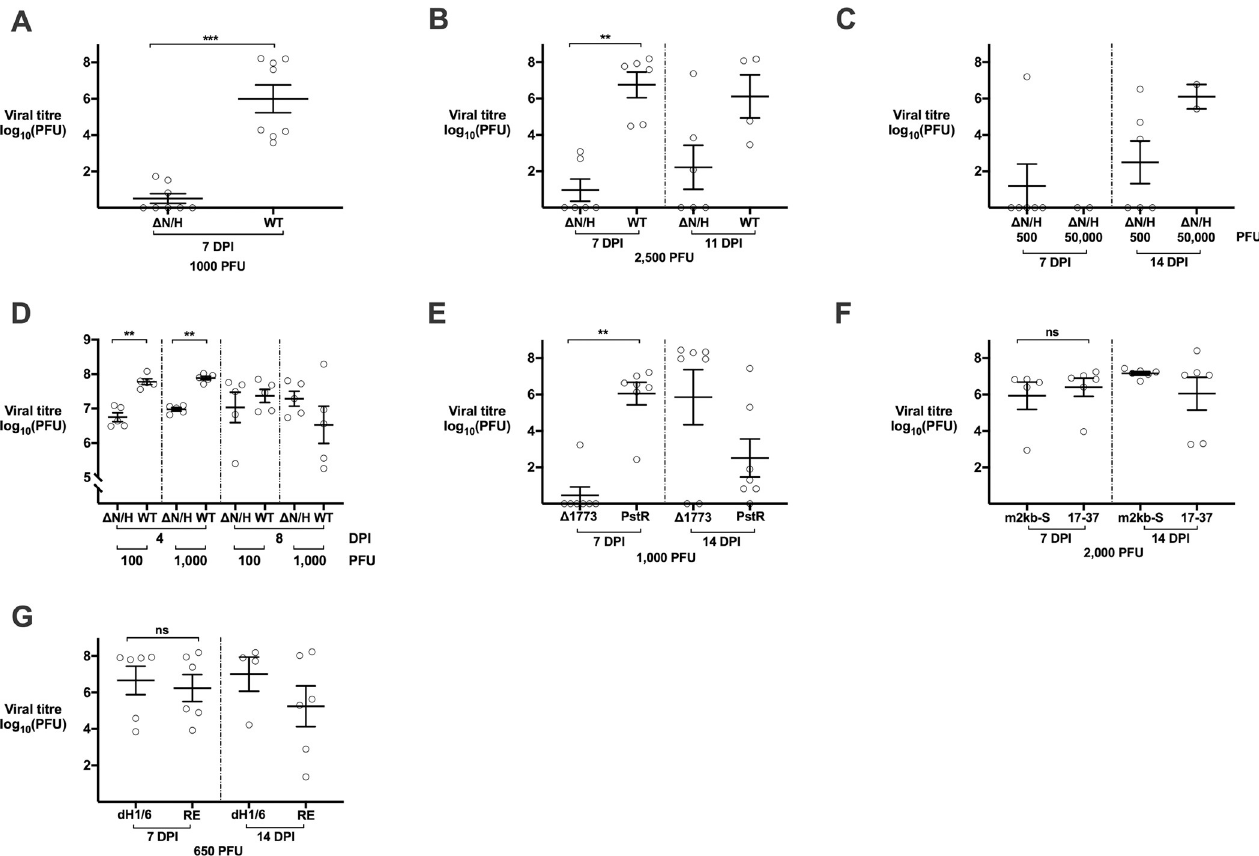
Fig 3. Replication of 17 syn + and LAT mutant viruses in human skin in vivo and cultured skin explants. Viral titres (log 10 PFU/implant ± SEM; each data point represents an individual replicate) recovered from: (A) in vivo skin xenografts infected with 1,000 PFU 17 Δ N/H ( Δ N/H) or 17 syn + (WT) at 7 DPI (n = 8); (B) in vivo skin xenografts infected with 2,500 PFU 17 Δ N/H or 17 syn + at 7 (n = 6) or 11 DPI (17 Δ N/H n = 6; 17 syn + n = 4); (C) in vivo skin xenografts infected with 500 or 50,000 PFU 17 Δ N/H at 7 or 14 DPI (500 PFU n = 6, 50,000 PFU n = 2); (D) cultured skin explants infected with 100 or 1,000 PFU 17 Δ N/H or 17 syn + at 4 or 8 DPI (n = 5); (E) in vivo skin xenografts infected with 1,000 PFU Δ 1773 or 17 Δ PstR (PstR) at 7 or 14 DPI (n = 7); (F) in vivo skin xenografts infected with 2,000 PFU m2kb-S or 17-37 at 7 (m2kb-S n = 5; 17-37 n = 6) and 14 DPI (n = 6); and (G) in vivo skin xenografts infected with 650 PFU 17dmiR-H1/H6 (dH1/6) and 17REdmiR-H1/H6 (RE) at 7 (n = 6) and 14 DPI (17dmiR-H1/H6 n = 4; 17REdmiR-H1/H6 n = 6). Mann-Whitney non- parametric unpaired two-tailed tests were performed, for which ns signifies p > 0.05, � p signifies � 0.05, �� signifies p � 0.01, ��� signifies p � 0.001, and ���� signifies p � 0.0001. The exact p values are (A) ��� p = 0.0002 for 17 Δ N/H vs. 17 syn + at 7 DPI; (B) �� p = 0.0022 for 17 Δ N/H vs. 17 syn + at 7 DPI; (C) N/A; (D) �� p = 0.0079 for 17 Δ N/H vs. 17 syn + at 4 DPI (100 PFU inocula) and �� p = 0.0079 for at 4 DPI (1000 PFU inocula); (E) �� p = 0.0012 for 1,000 PFU inocula Δ 1773 vs. 17 Δ PstR at 7 DPI; (F) ns p = 0.1926 for m2kb-S vs. 17-37 at 7 DPI; and (G) ns p = 0.9372 for 17dmiR-H1/H6 vs. 17REdmiR-H1/H6 at 7 DPI.